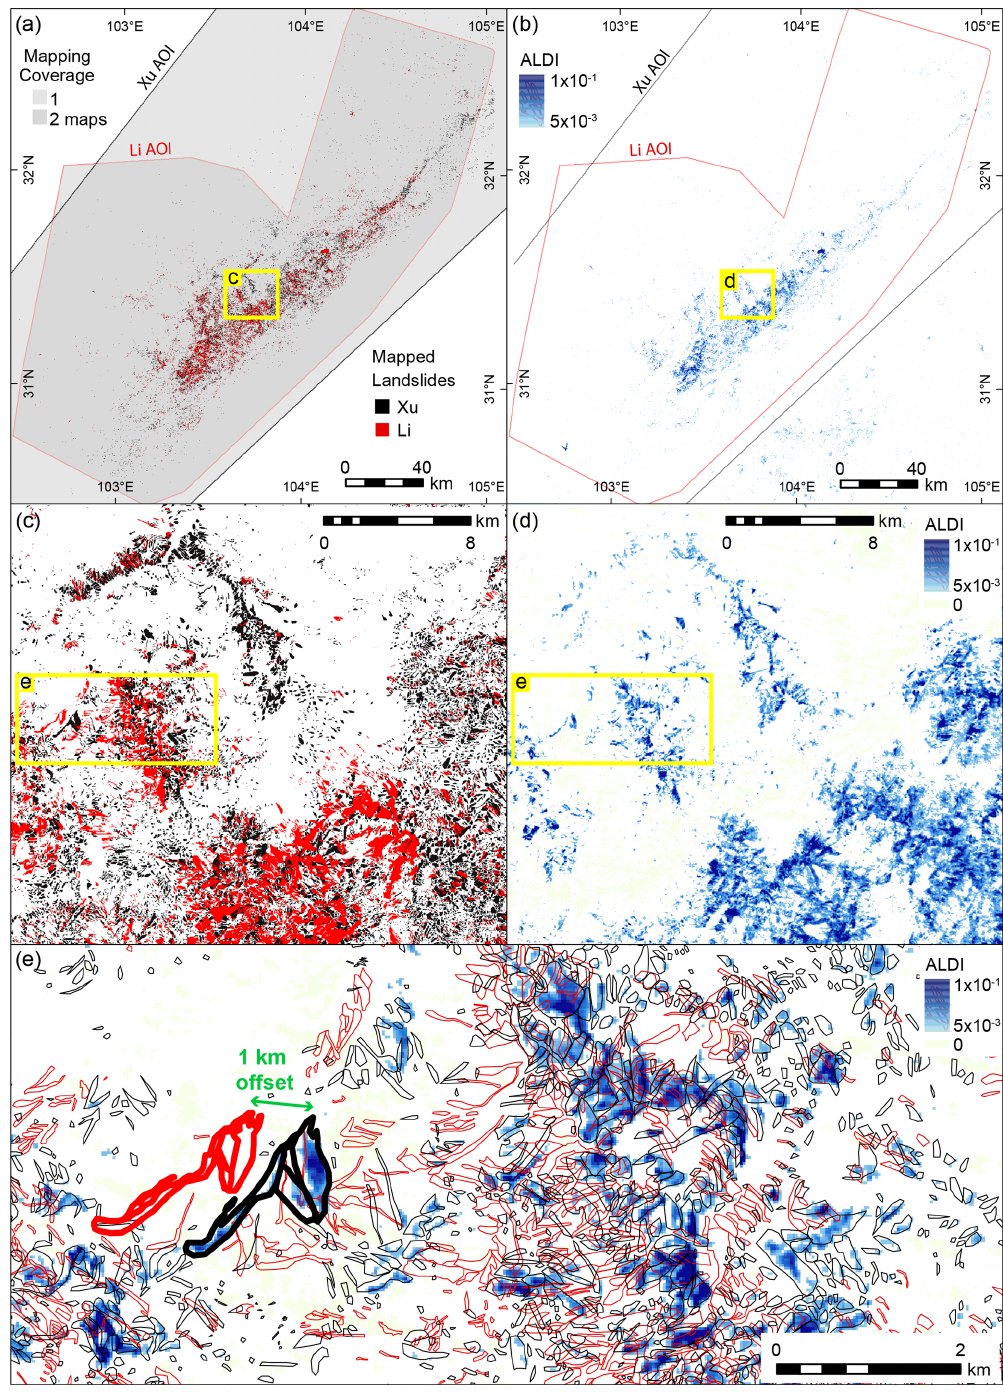
Figure 8. Manually mapped landslides and ALDI classifier results for the Wenchuan study site. (a) Mapped landslides at the scale of the full study area with AOIs shown in grey; Xu and Li refer to the inventories of Xu et al. (2014) and Li et al. (2014), respectively. (b) ALDI values for the full study area. (c) Mapped landslides and (d) ALDI values for a subset of the study area. (e) Detailed view of mapped landslides overlain on ALDI values. Yellow boxes in each panel show the locations of nested panels (e.g. c in a and d in b ). Thicker outlines in panel (e) indicate landslides of very similar geometry that are offset by ∼ 1km in the different inventories; the ALDI pattern suggests that the map by Xu et al. (2014) is more likely to be correctly georeferenced in this